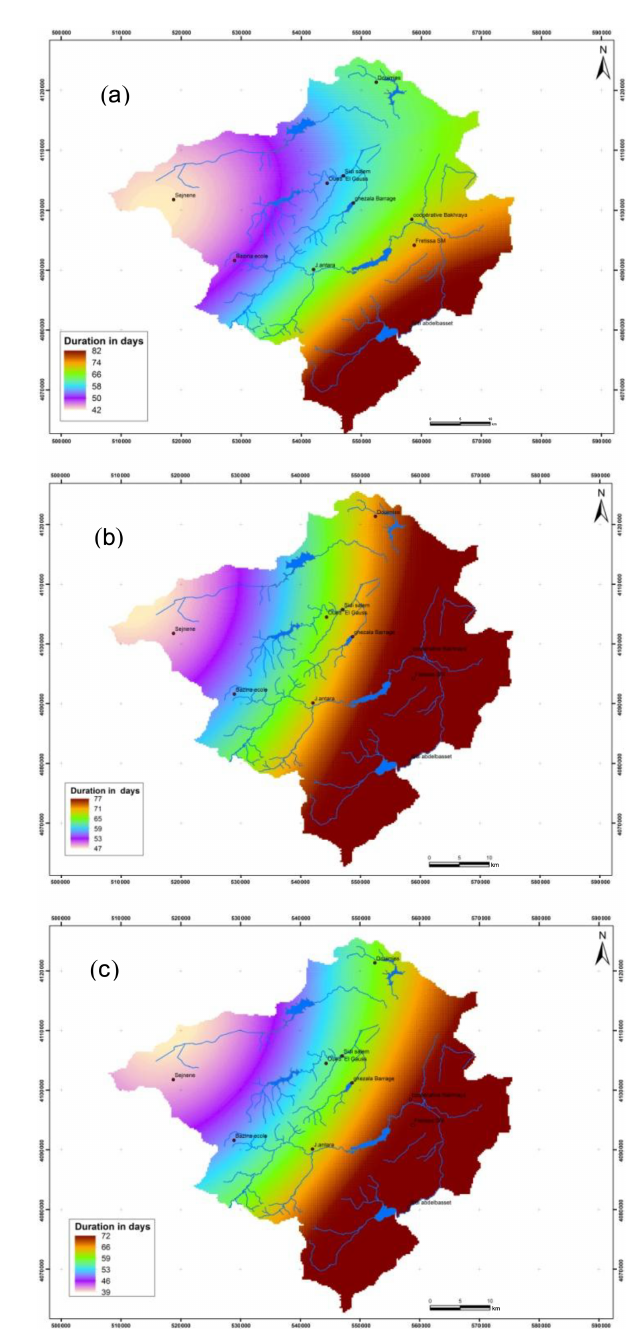
Figure 6. Maximum dry events: (a) observed in 42 years (1968– 2010); (b) predicted using the E distribution; (c) predicted using Gumbel distribution.